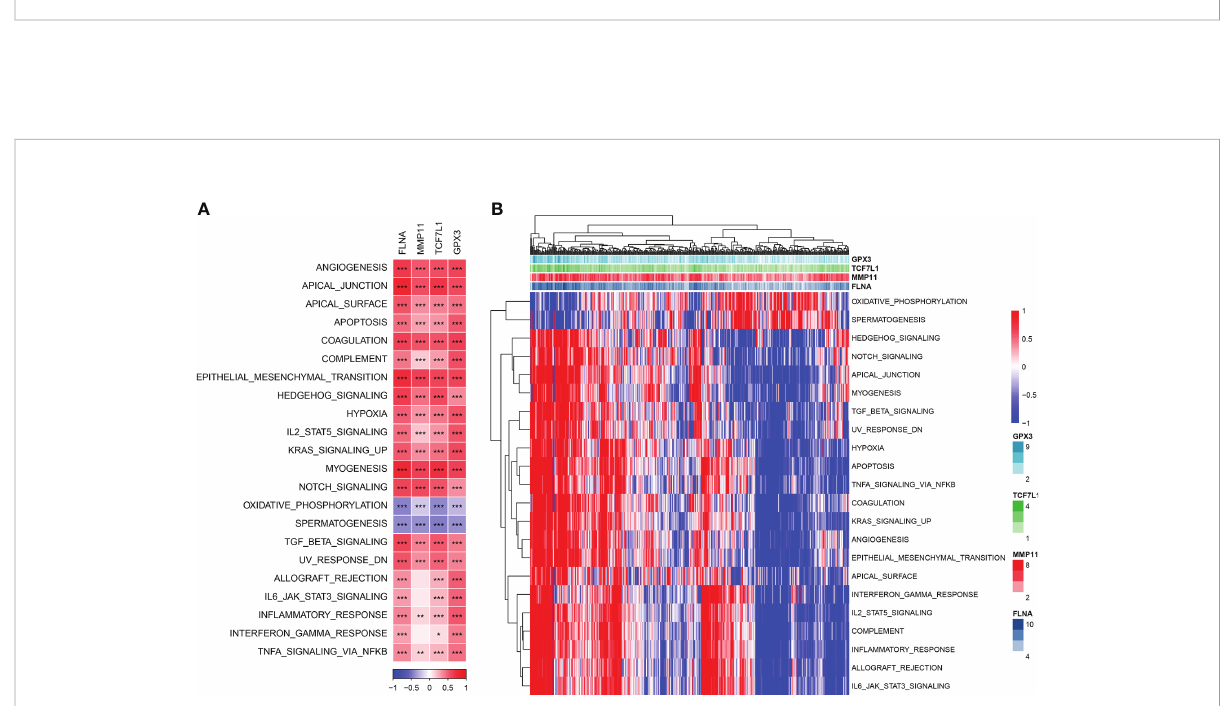
FIGURE 6 (A) Heat map of the correlation between genes and pathways; (B) Heat map of the enrichment scores of key pathways. *P< 0.05, **P < 0.01, ***P <